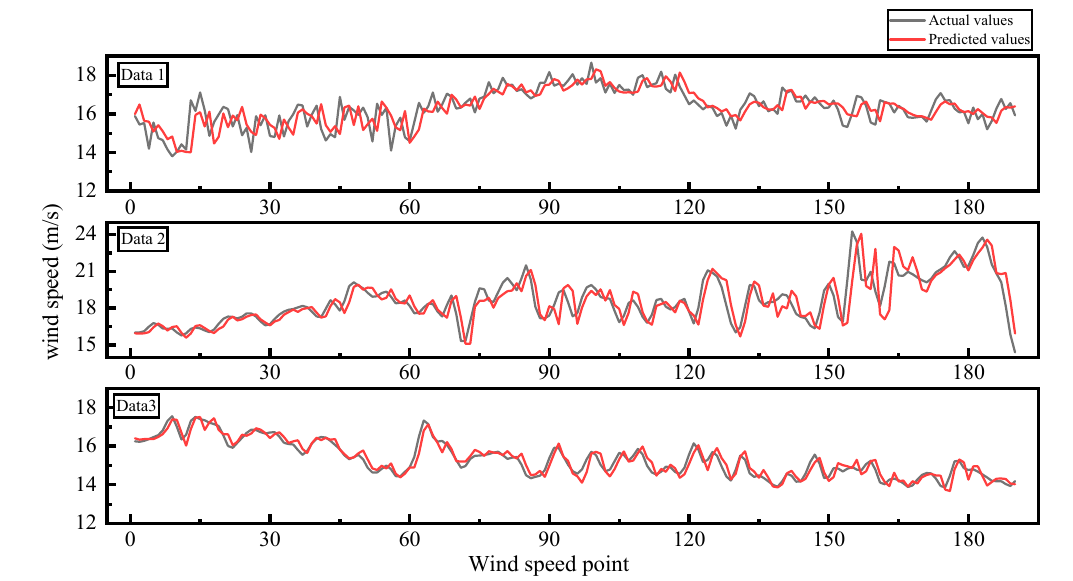
Figure 4. Predictive and actual values of Datasets 1–3.